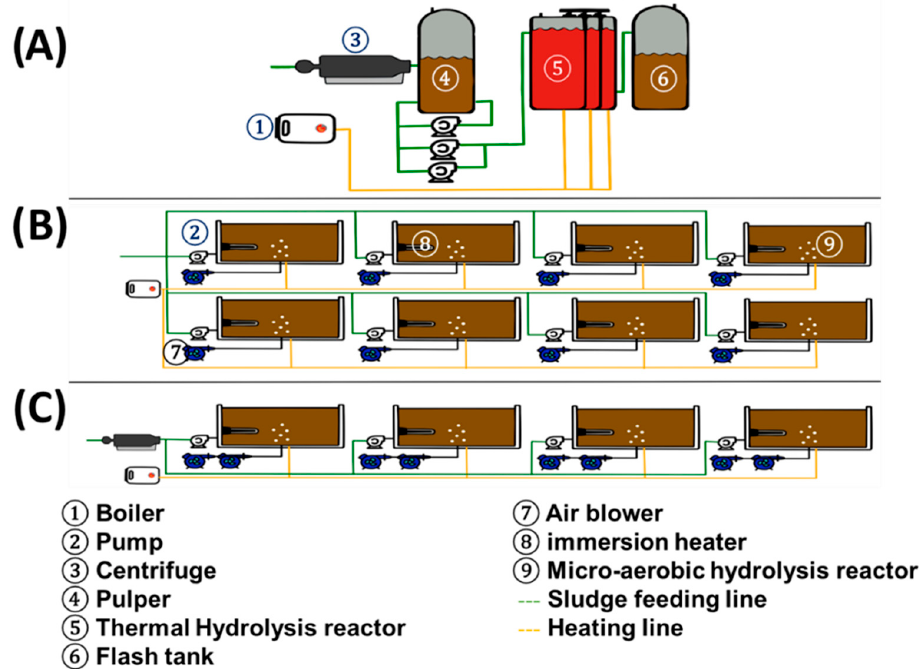
Figure 1. Schematic view of a process line of: ( A ) Thermal pre-treatment process with thickened activated sludge; ( B ) Micro-aerobic pre-treatment process with activated sludge; and ( C ) Micro- aerobic pre-treatment process with thickened activated sludge.